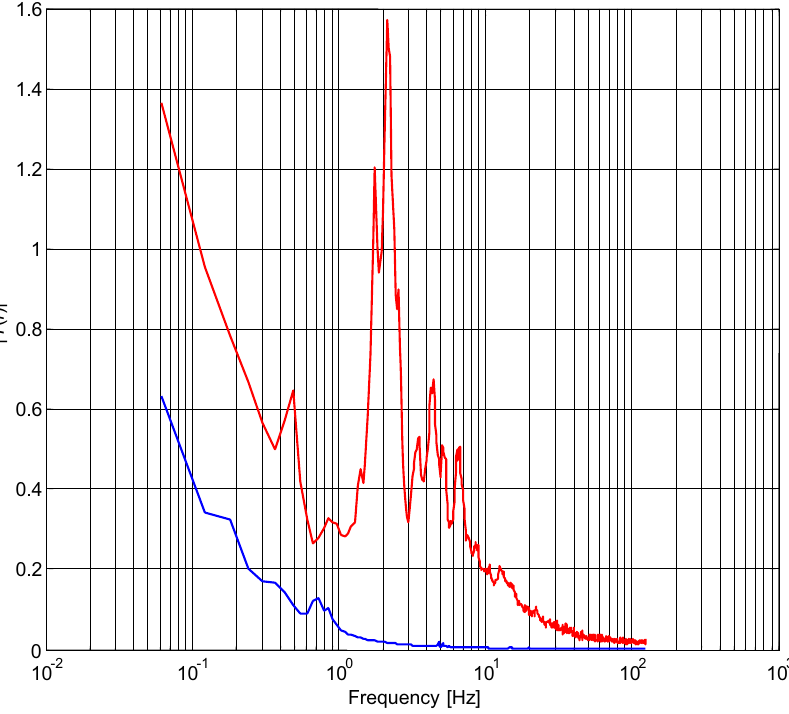
Fig. 7 The spectra of CNAP2GO ’ s contact pressure. The frequency content of the contact pressure p c ( t ) (blue line) is shown in comparison to the frequency content of the whole pulsatile blood pressure signal (red